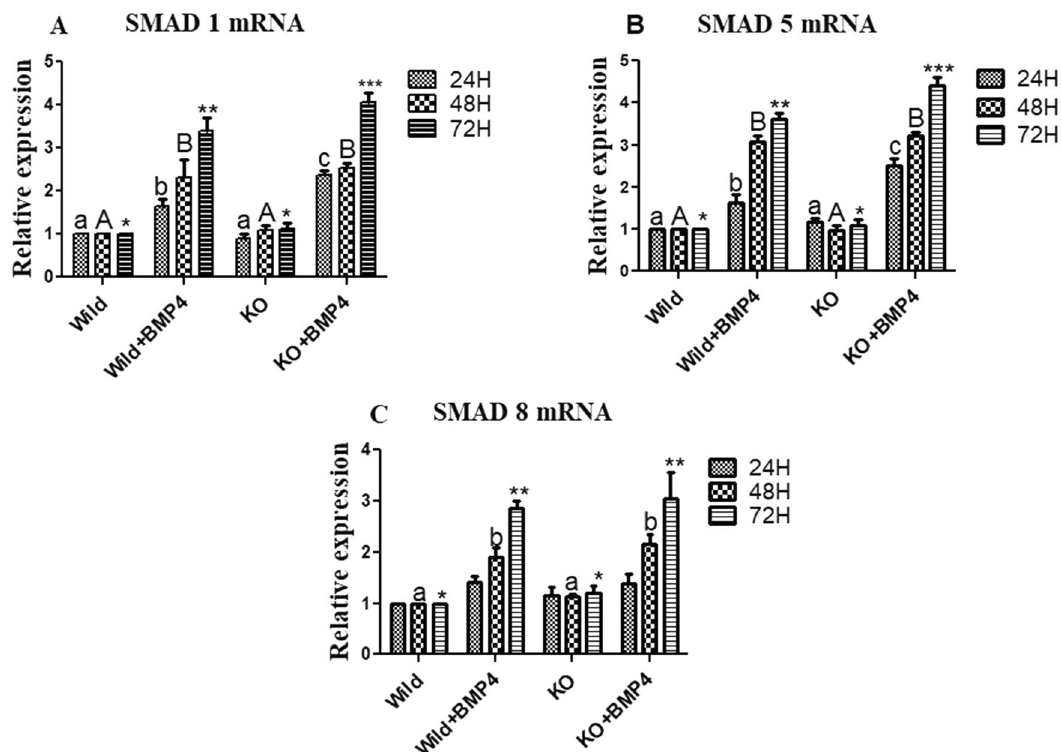
Figure 3. Effect of BMPR-IB gene KO on expression of Smad1, Smad5 and Smad 8 transcripts in in vitro cultured granulosa cells stimulated with BMP-4 (50 ng/ml) for three different time durations (24, 48 and 72 h). All values are shown as mean ± SEM. Different superscripts denote statistically different values ( p < 0.05). Abbreviations: WT indicate wild type cells, WT + BMP-4 indicate wild cells treated with BMP-4 (50 ng/mL), KO indicate BMPR-IB gene knock out cells. KO + BMP-4 indicate KO cells treated with BMP-4(50